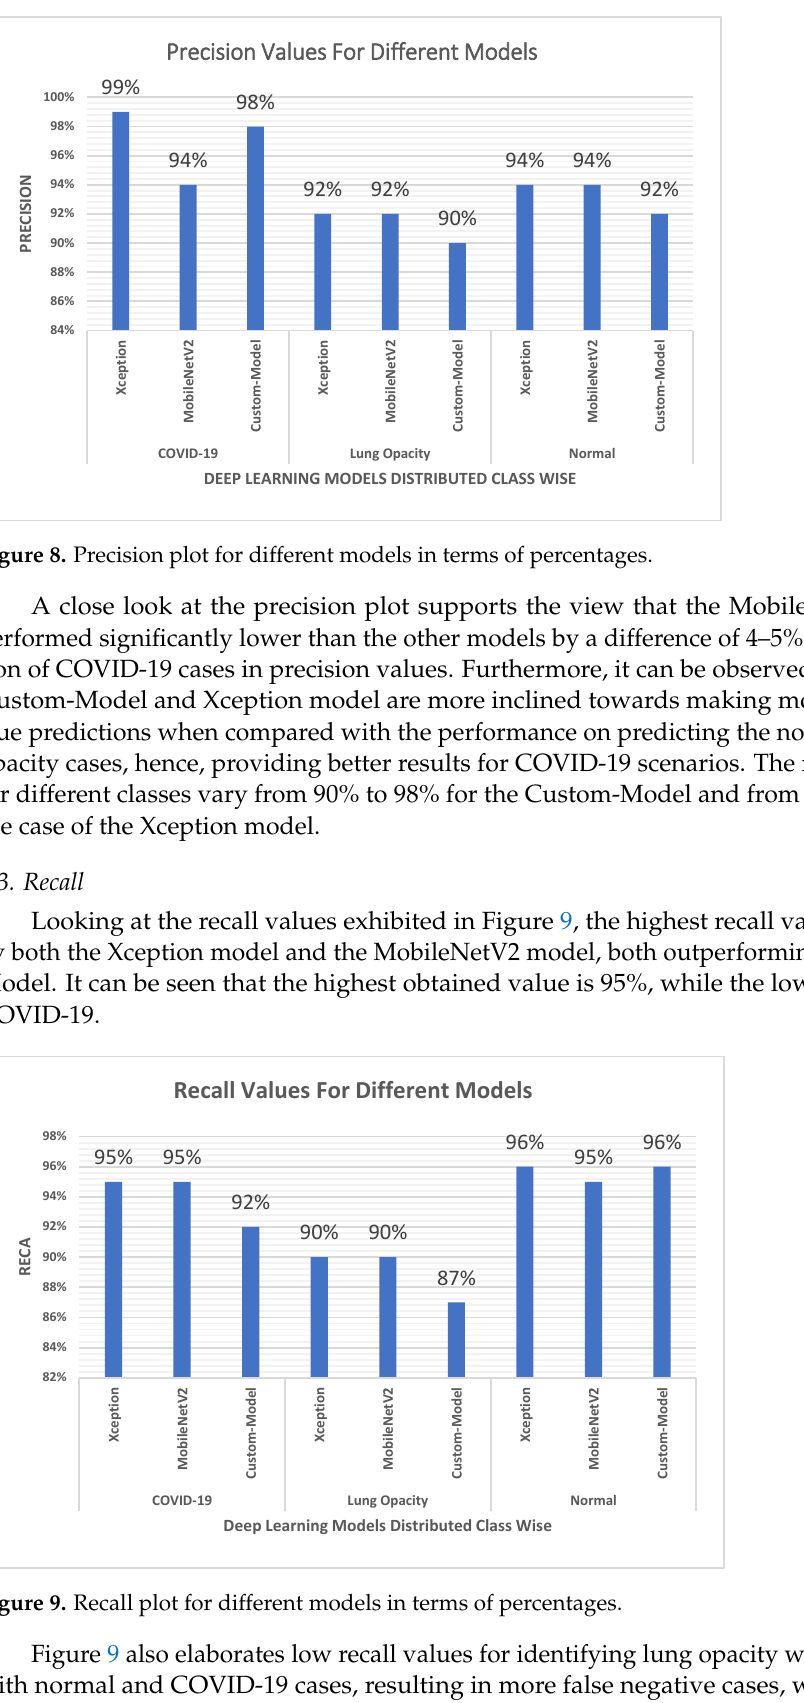
Figure 10. F1 score plot for different models in terms of percentages.